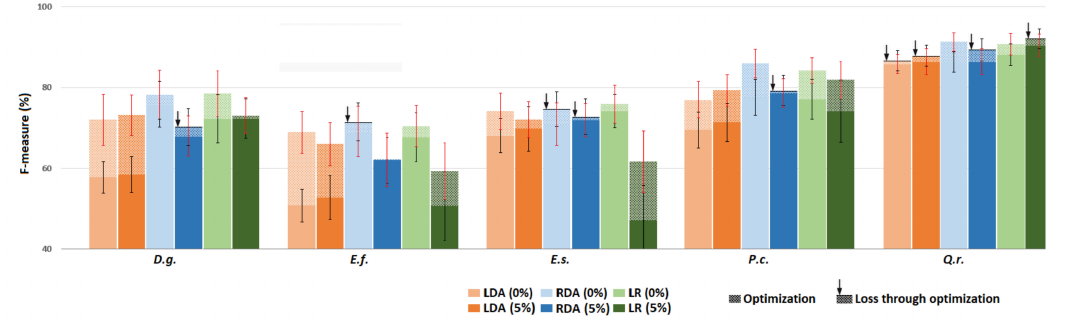
Figure 5. Object level F-measure (and its standard deviation) of species binary classifier trained with either 0% or 5% mislabeling of non-focal class. Paler color represents performance after applying an optimization step (see text). An arrow indicates cases when optimization decreased